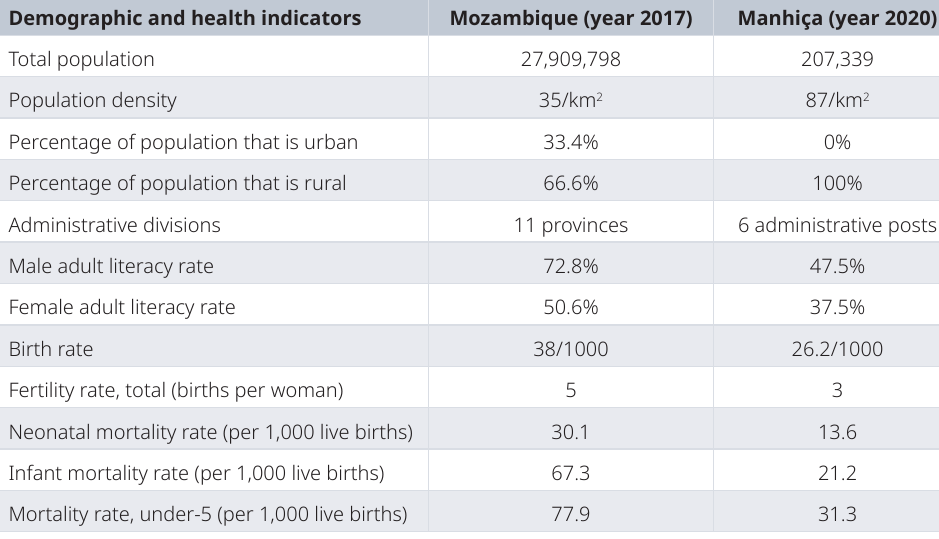
Table 1. Selected demographic and health indicators in Mozambique and Manhiça.